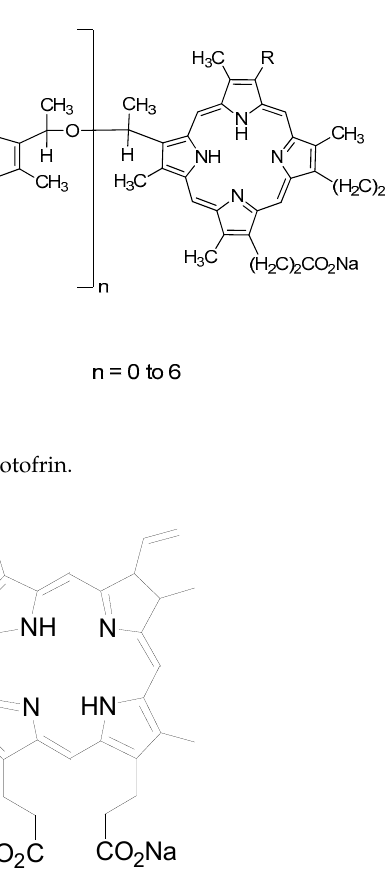
Figure 2. Structure of sinoporphyrin sodium (C 68 H 66 N 8 O 9 Na 4 ).